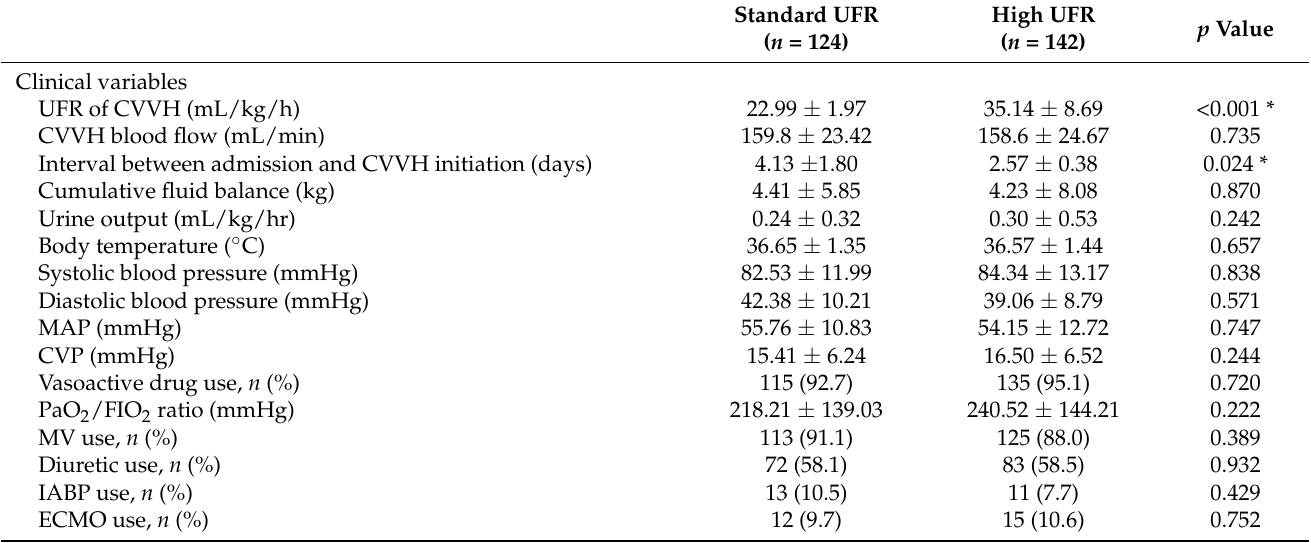
Table 2. Characteristics at the initiation of continuous venovenous hemofiltration in the standard and high ultrafiltration rate